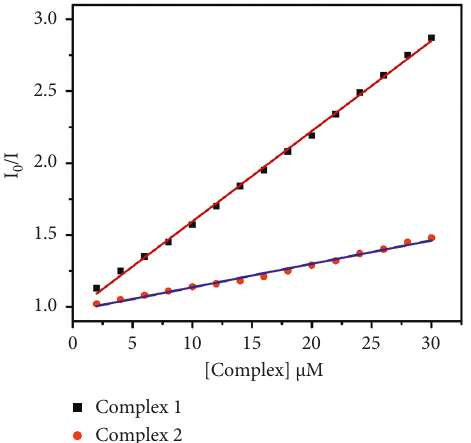
Figure 13: Stern–Volmer plots of I